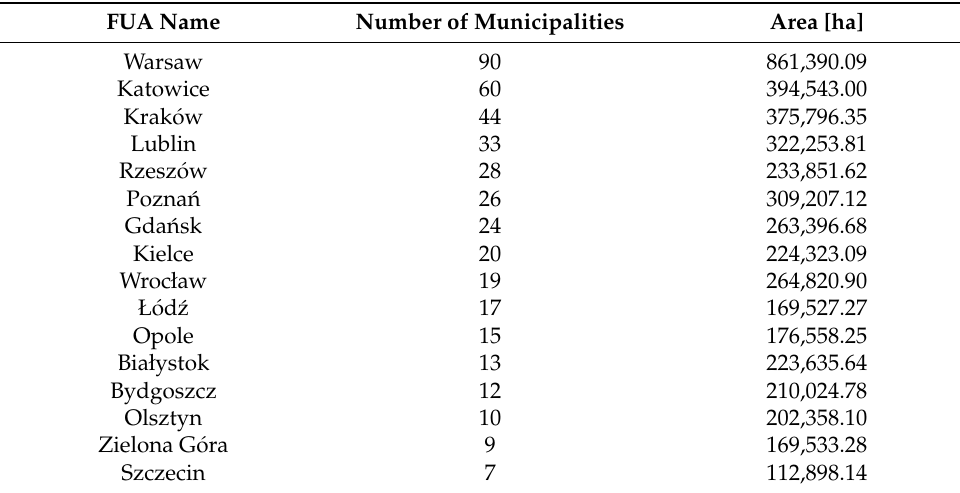
Table 1. Investigated FUAs, numbers of municipalities, and area of FUAs.